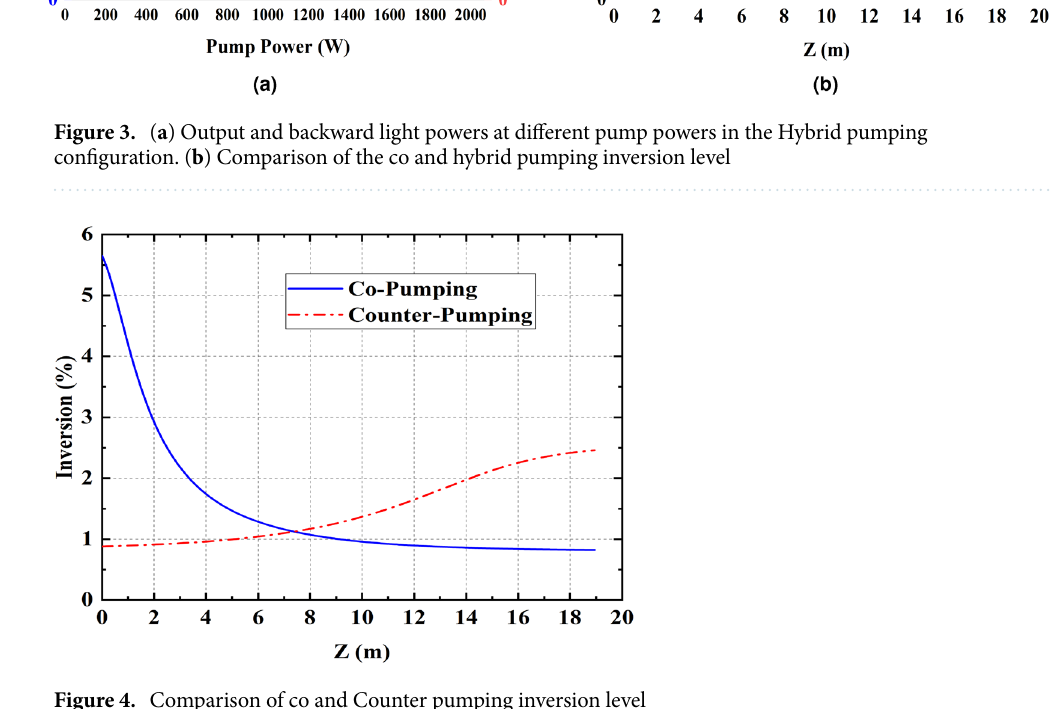
Figure 4. Comparison of co and Counter pumping inversion